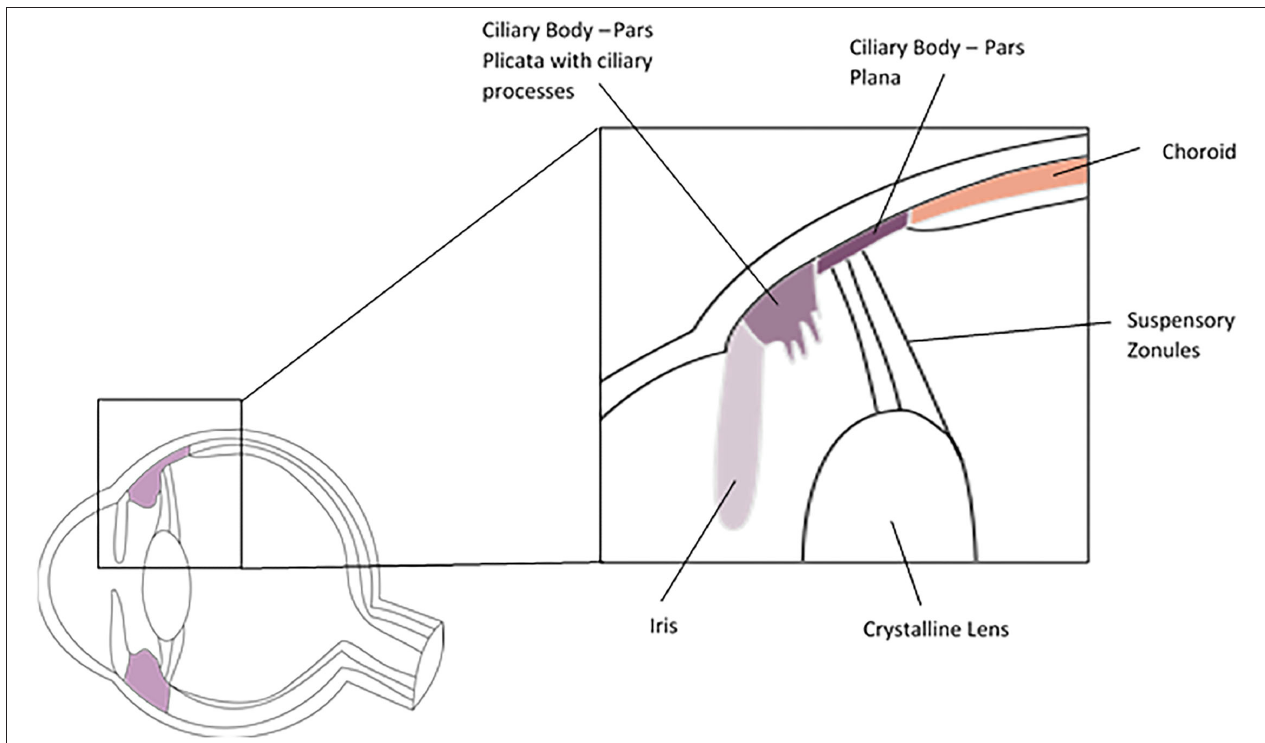
FIGURE 3 | Cross section of the ciliary